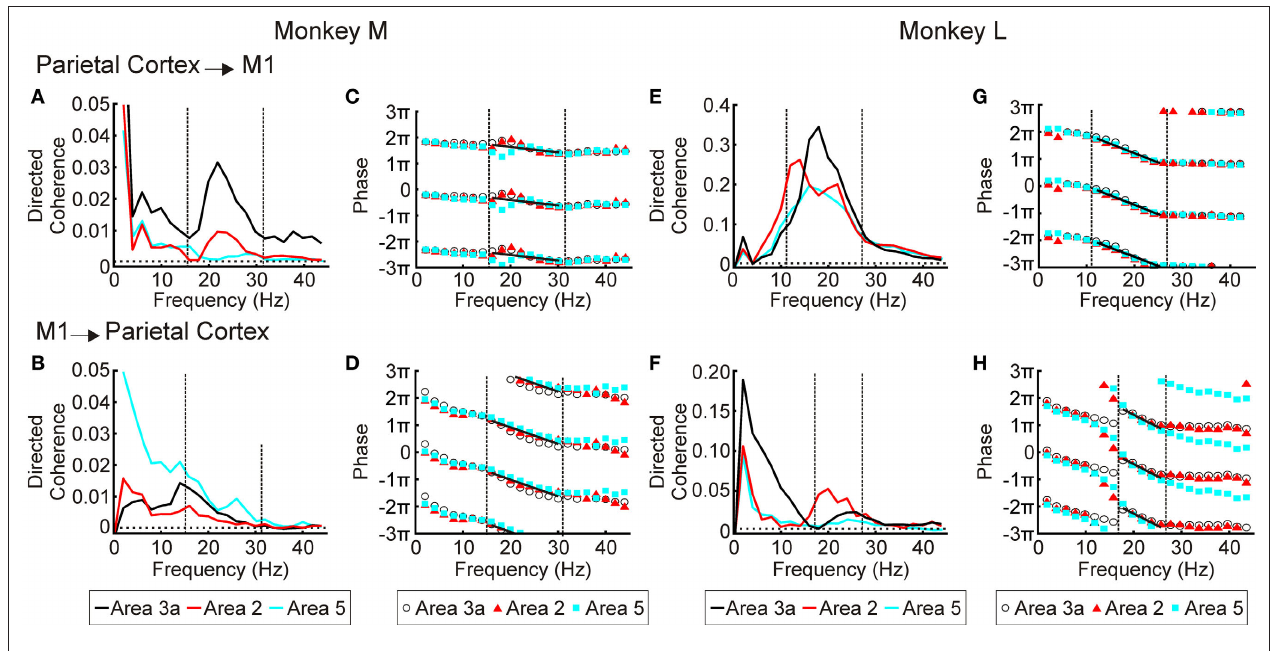
Figure 6 | LFP–M1 LFP directed coherence. (A) directed coherence spectra for monkey M for 3a/2/5 → M1 direction. (B) as (A) , but for M1 → 3a/2/5 direction. The highest significance level out of area 3a, area 2 and area 5 is shown but the difference in 95% significance levels between the different areas is small compared to the size of the directed coherence. (C,D) as (A,B) for